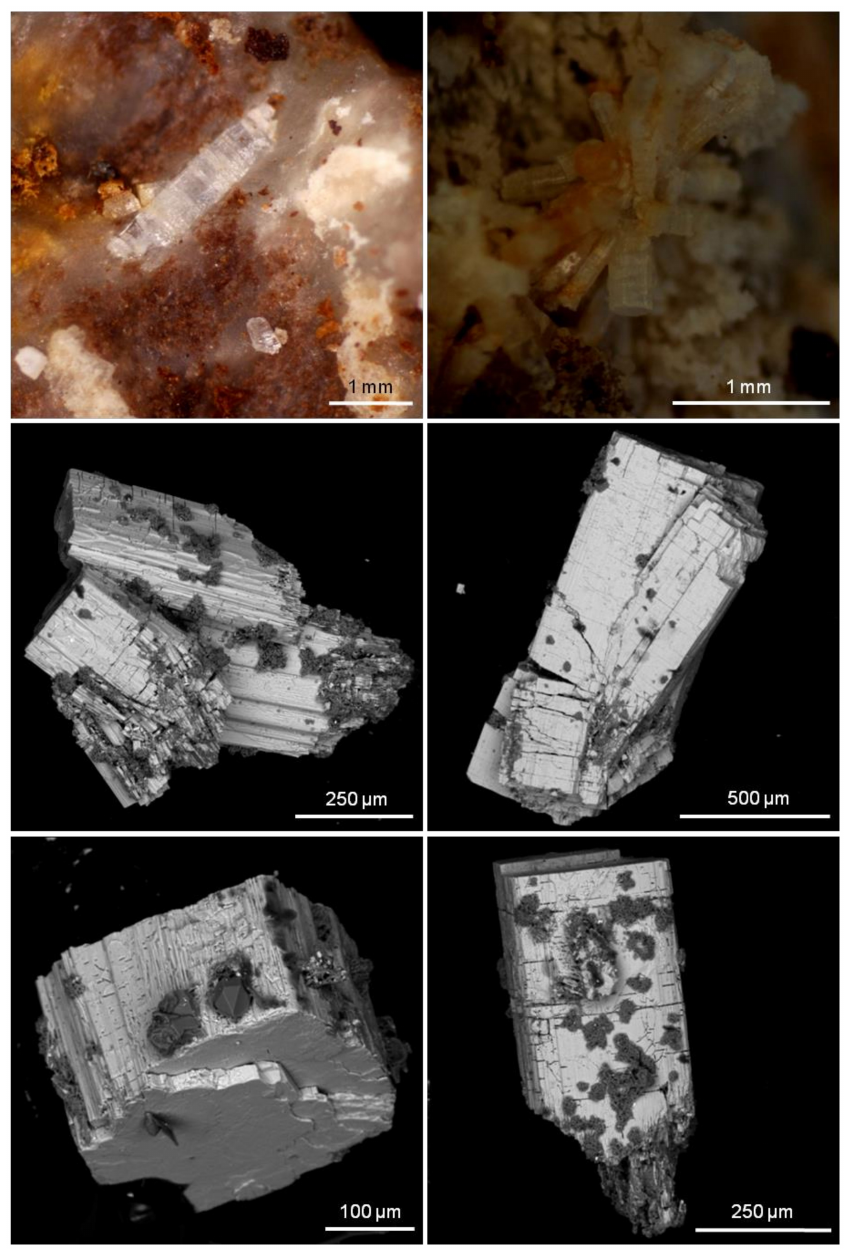
Figure 3. Discrete crystal fragments and intergrowths of rippite from the Chuktukon calciocarbonatite, ordinary light and BSE images (holotype sample 546–193.5). The rock fragments were partially or completely dissolved by diluted HCl acid. Some faces of rippite crystals are partially covered by